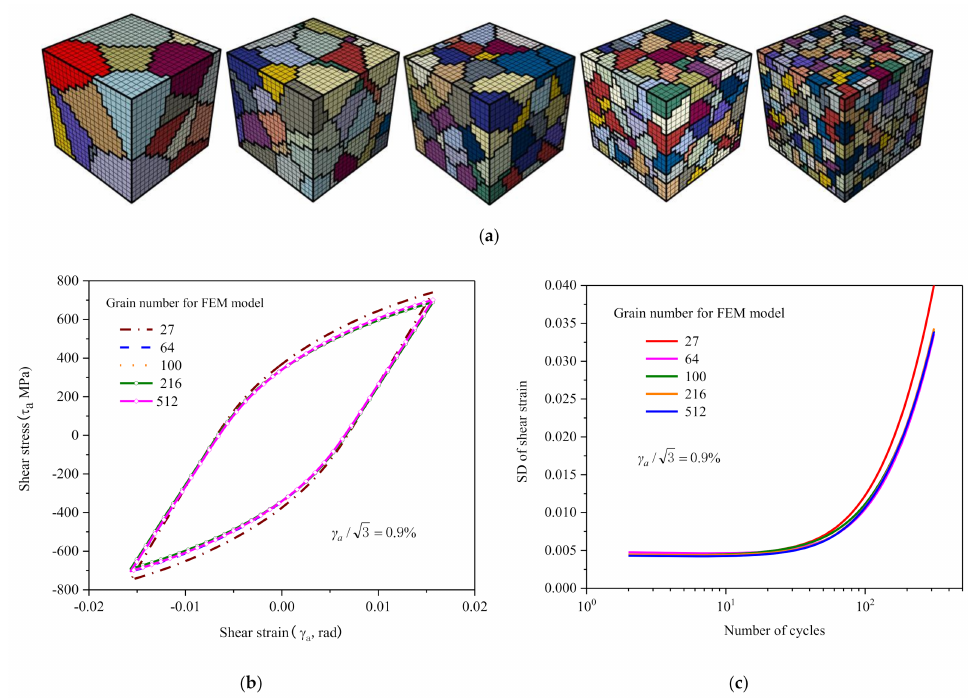
Figure 8. Models with the same number of 8000 elements: ( a ) containing 27, 64, 100, 216 and 512 grains; ( b ) comparison of hysteresis loops calculated by different models; ( c ) shear standard deviations vs. number of cycles for model varying number of grains.